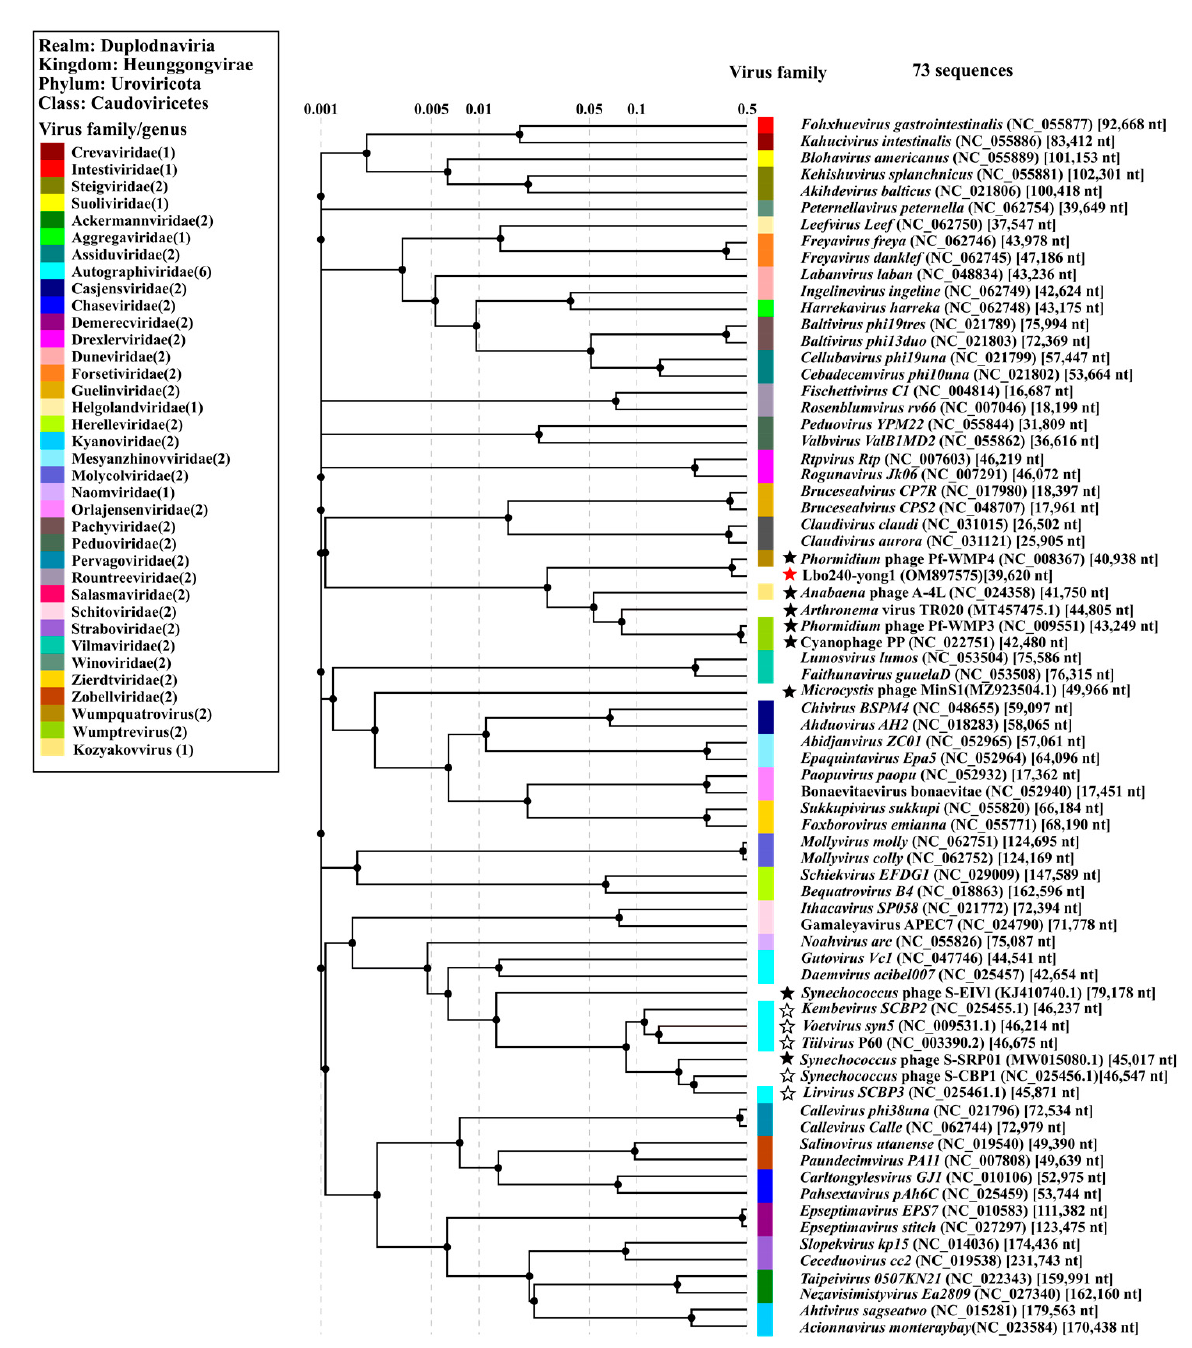
Figure 4. Proteomic tree based on the complete genome sequences of L. boryana cyanophage Lbo240-yong1 (red star), all six remaining Podovirus-like freshwater cyanophages with reported genomes, one Siphoviridae-like freshwater cyanophage (black star) capable of infecting L. boryana , five Podovirus-like marine cyanophages (black hollow star), and 59 representative bacteriophages of 33 families of the Caudovirales class. The proteomic tree was generated using ViPTree online, based on the genome-wide similarities determined by tBLASTx. Cyanophage family assignments, according to the official ICTV classification (2022), are provided with different color bars.